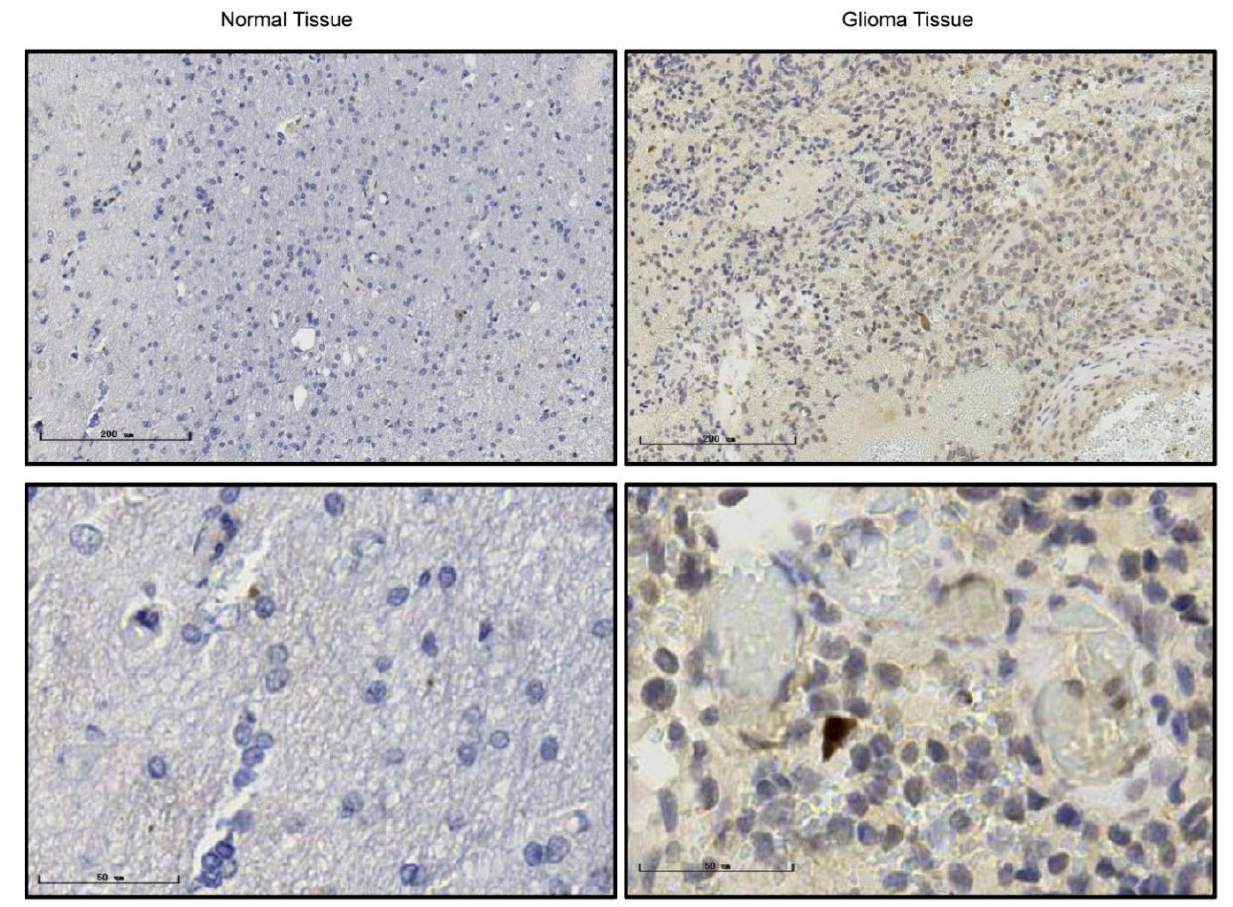
Figure 5. The representative results of IHC.